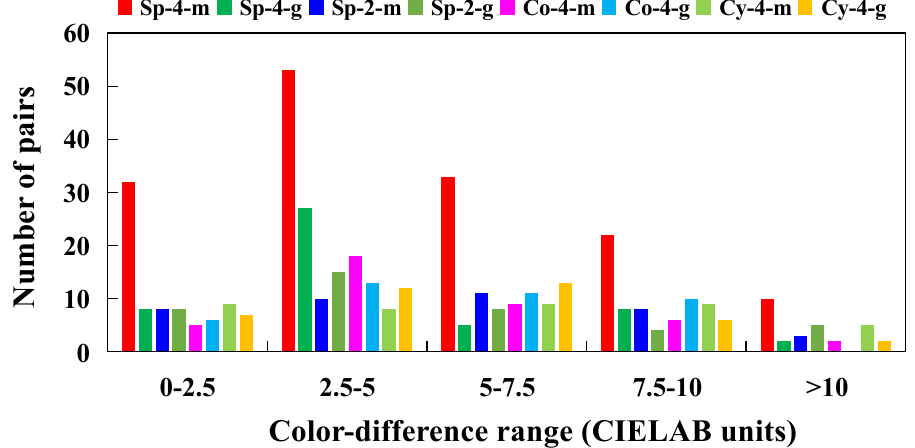
Figure 1. Numbers of pairs with different color-difference magnitudes for each of the 8 phases (see main text).